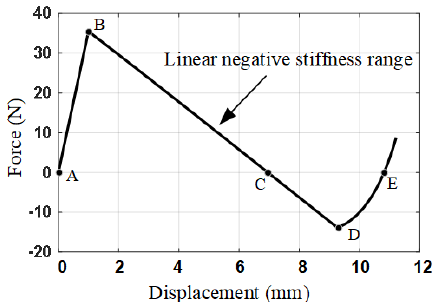
Figure 5. The axial force–displacement curve of the conventional bistable negative-stiffness compliant